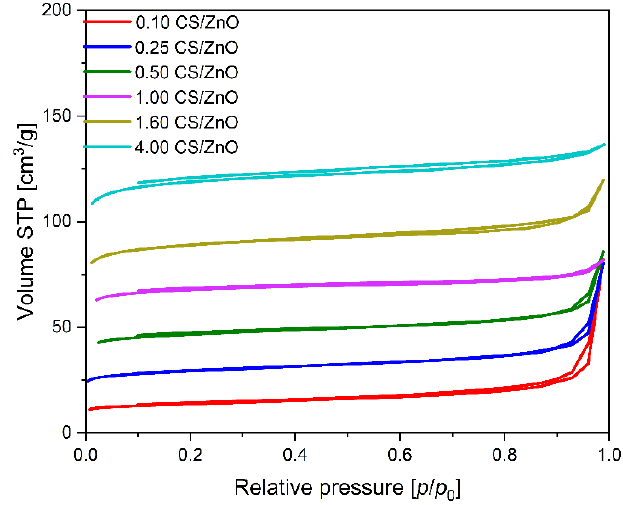
Figure 5. Nitrogen adsorption–desorption isotherms of CS/ZnO composites.